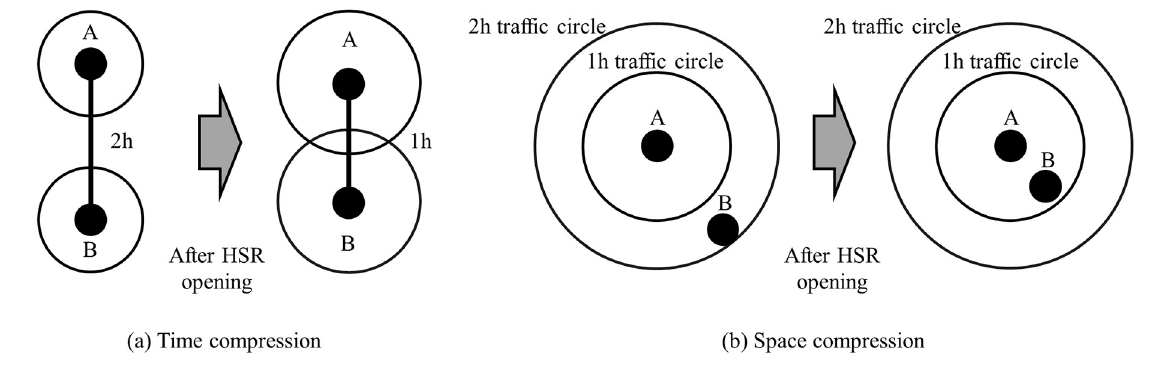
Fig 1. The time-space compression effect of HSR. (a) Time compression and (b) Space compression.